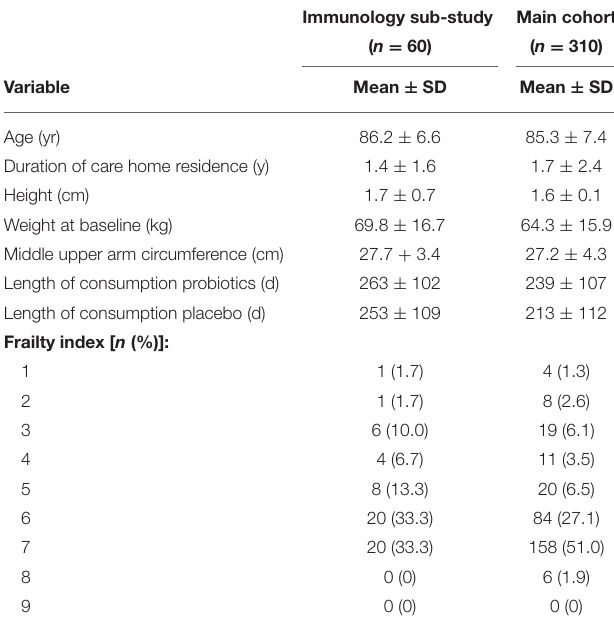
TABLE 1 | General characteristics of the participants in the PRINCESS trial (main cohort) and in the immunology